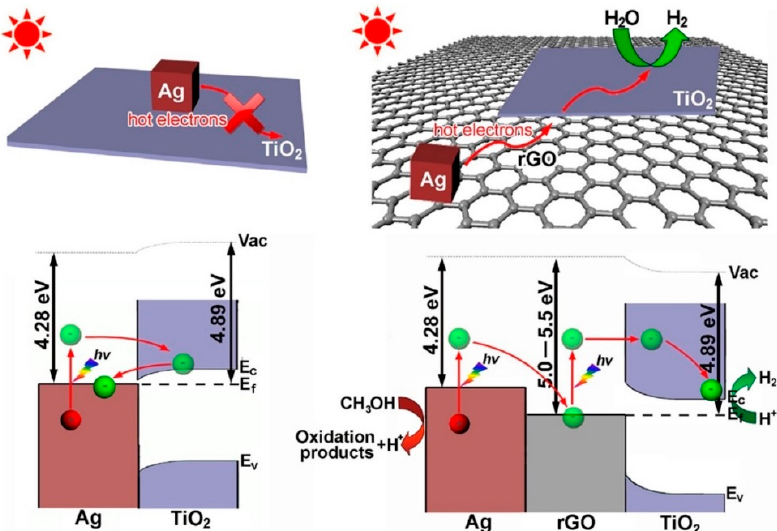
Figure 8. Schematic illustrating photocatalytic mechanism for Ag-TiO 2 and Ag-rGO-TiO 2 samples under visible-light irradiation. Reproduced with permission from Reference [95]; copyright (2018), Elsevier.